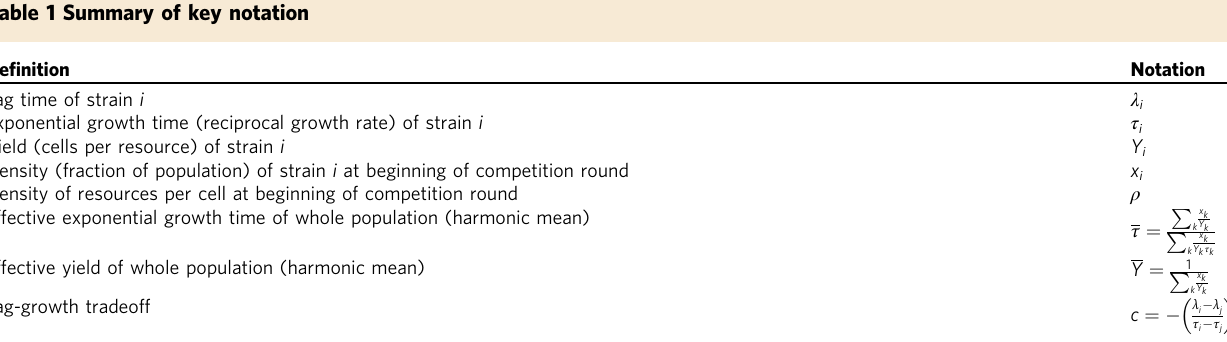
Table 1 Summary of key notation De fi nition Notation Lag time of strain i λ i Exponential growth time (reciprocal growth rate) of strain i τ i Yield (cells per resource) of strain i Y i Density (fraction of population) of strain i at beginning of competition round x i Density of resources per cell at beginning of competition